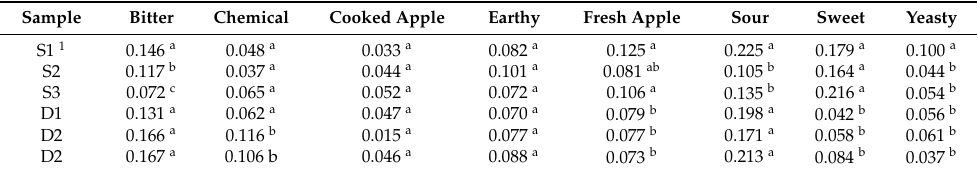
Table 3. The average proportion of experienced panellists’ citations of the TCATA sensory attributes. Sample